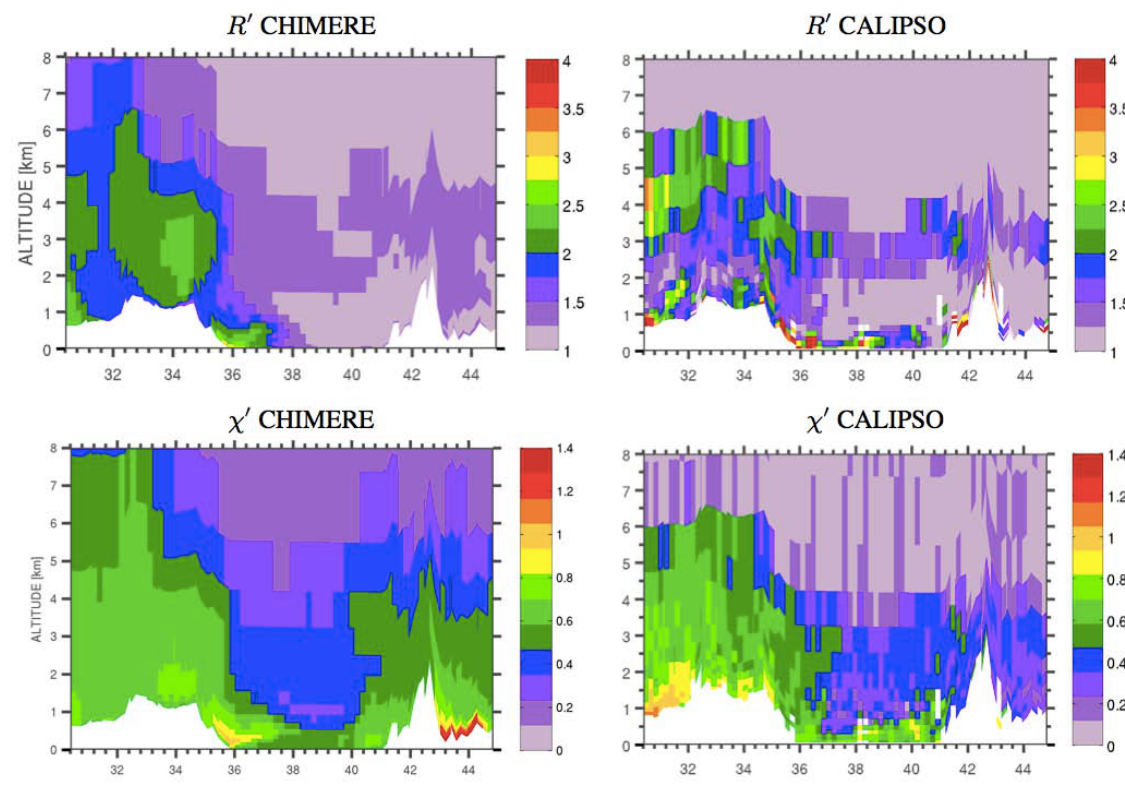
Fig. 16. Same as Fig. 14, but for the nighttime portion of the orbit of the 14 July